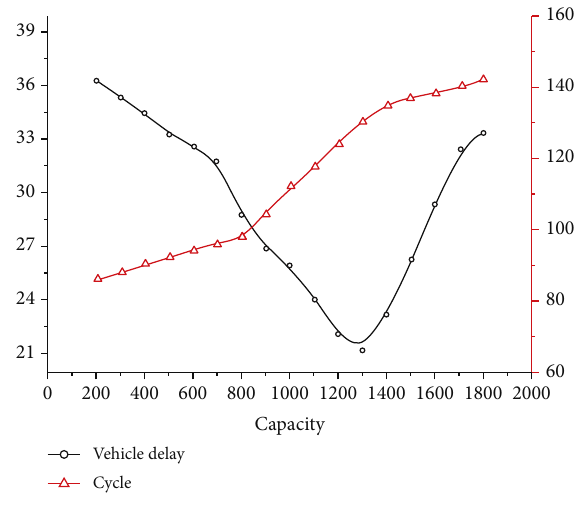
Figure 9: The impact of capacity on signal